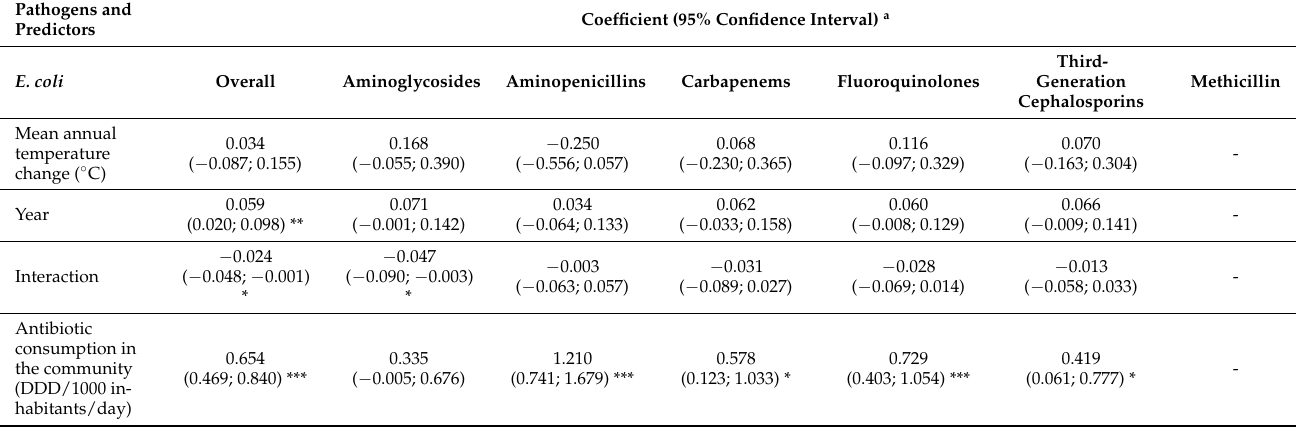
Table 1. Unadjusted and adjusted multivariable analyses to evaluate the linear relationship of antimi- crobial resistance with temperature change and other predictors, by pathogen and antibiotic